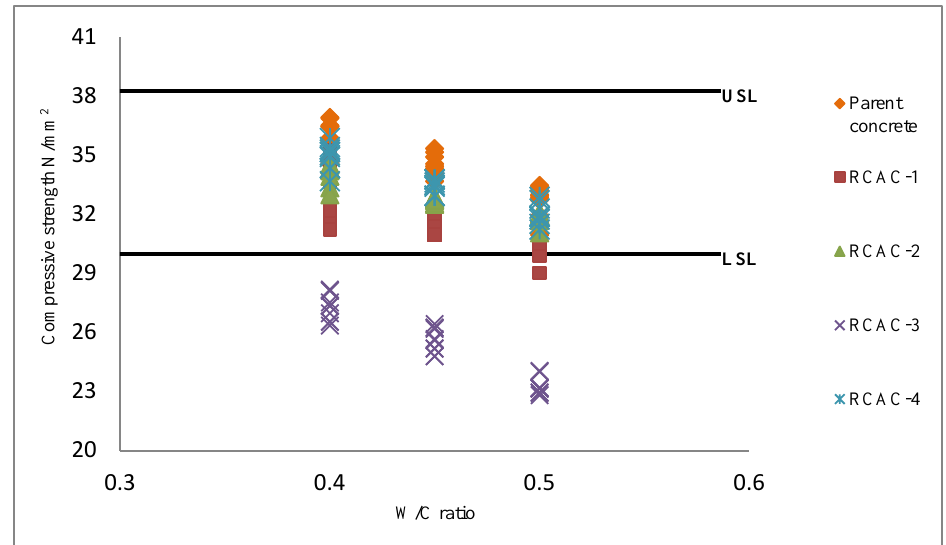
Figure 4. Statistical analysis of compressive strength of M30